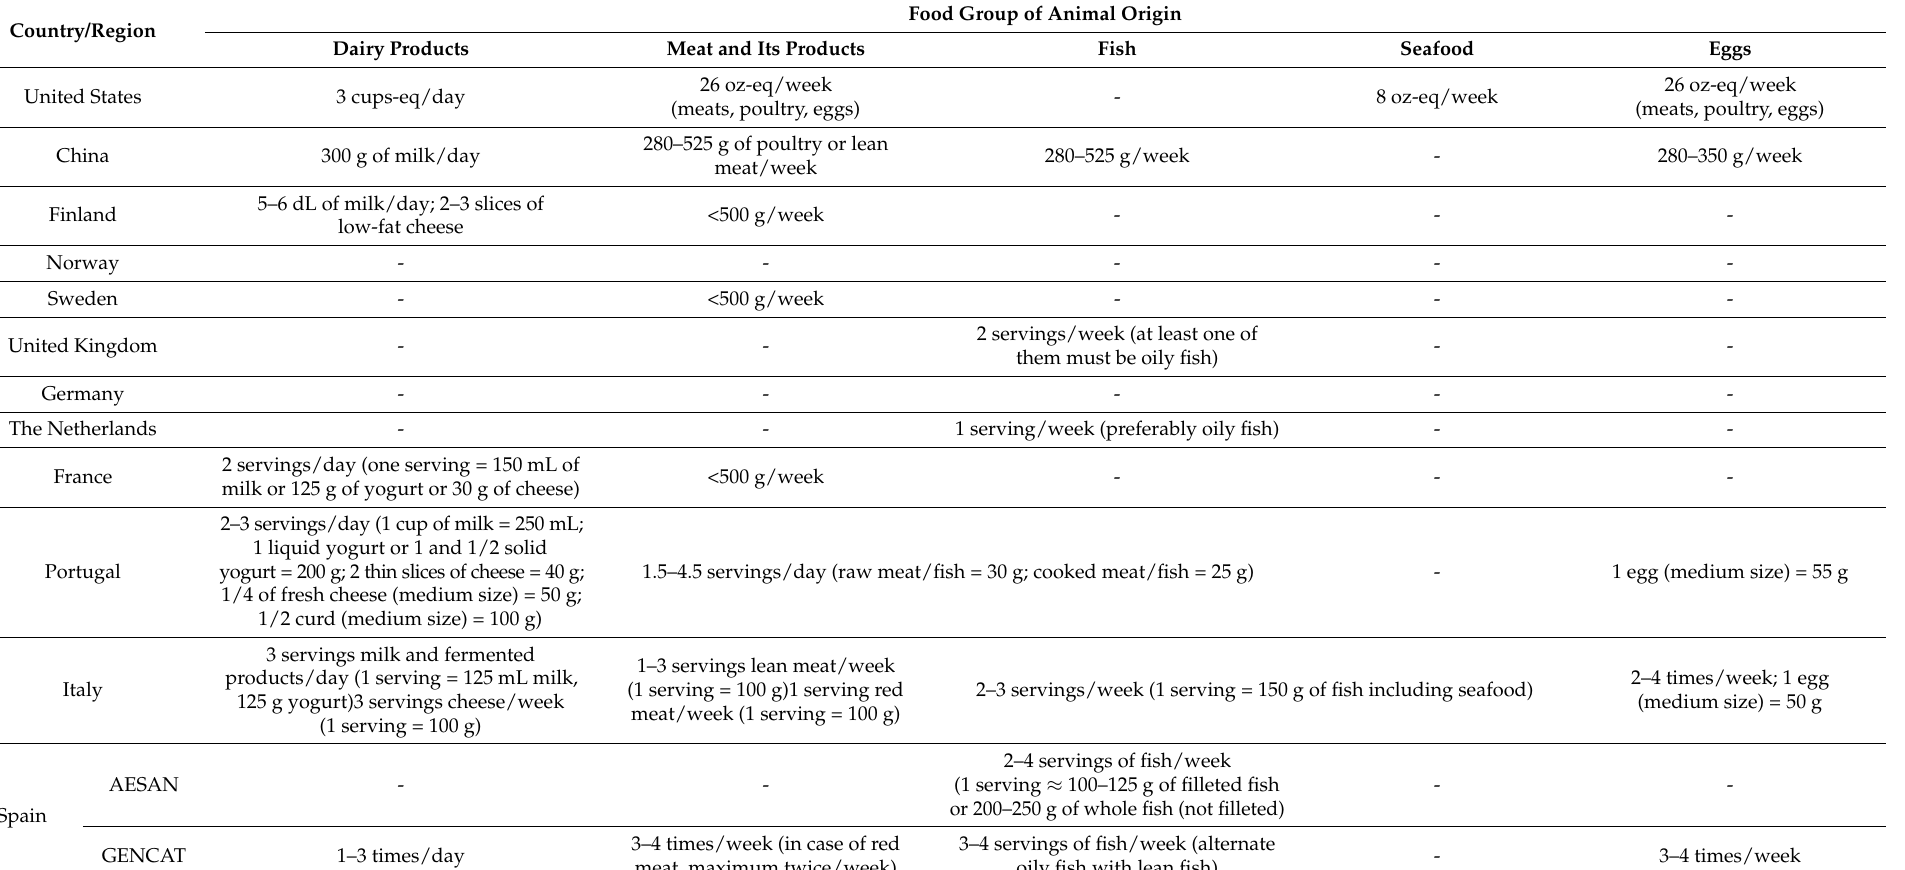
Table 5. Dietary recommendations for food groups of animal origin established by the international food guides selected in the present